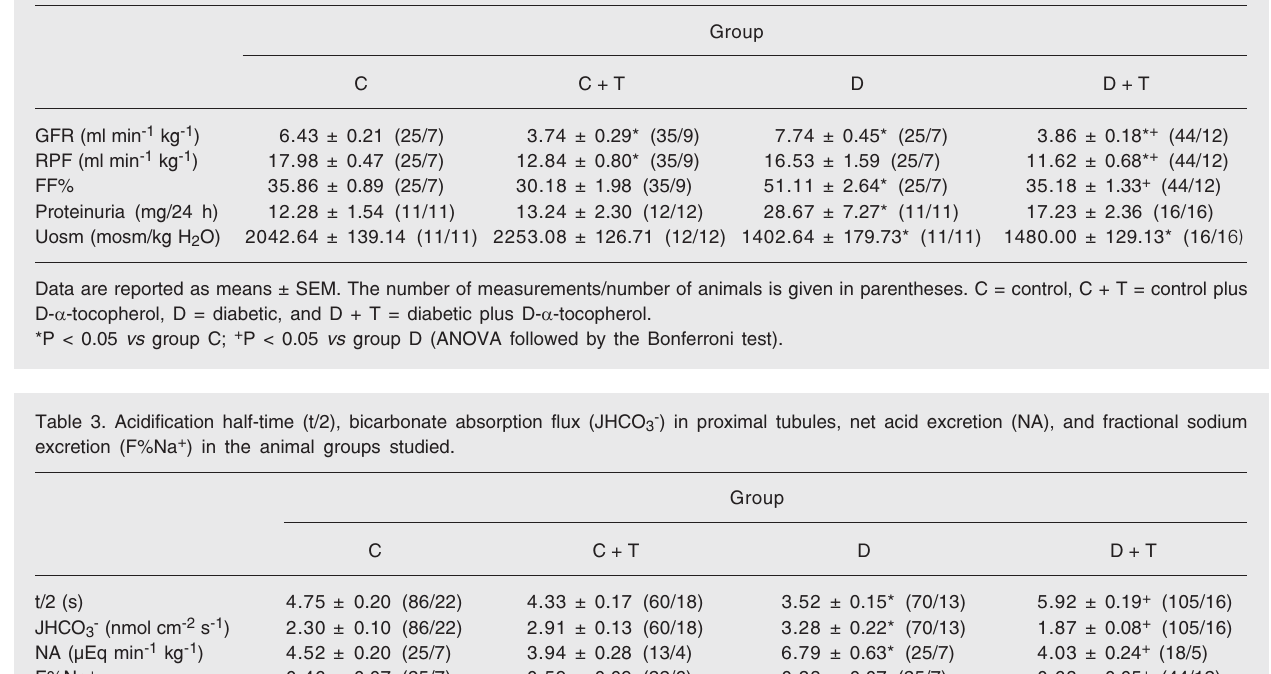
Table 2. Glomerular filtration rate (GFR), renal plasma flow (RPF), filtration fraction% (FF%), proteinuria, and urine osmolarity (Uosm) in the animal groups studied.